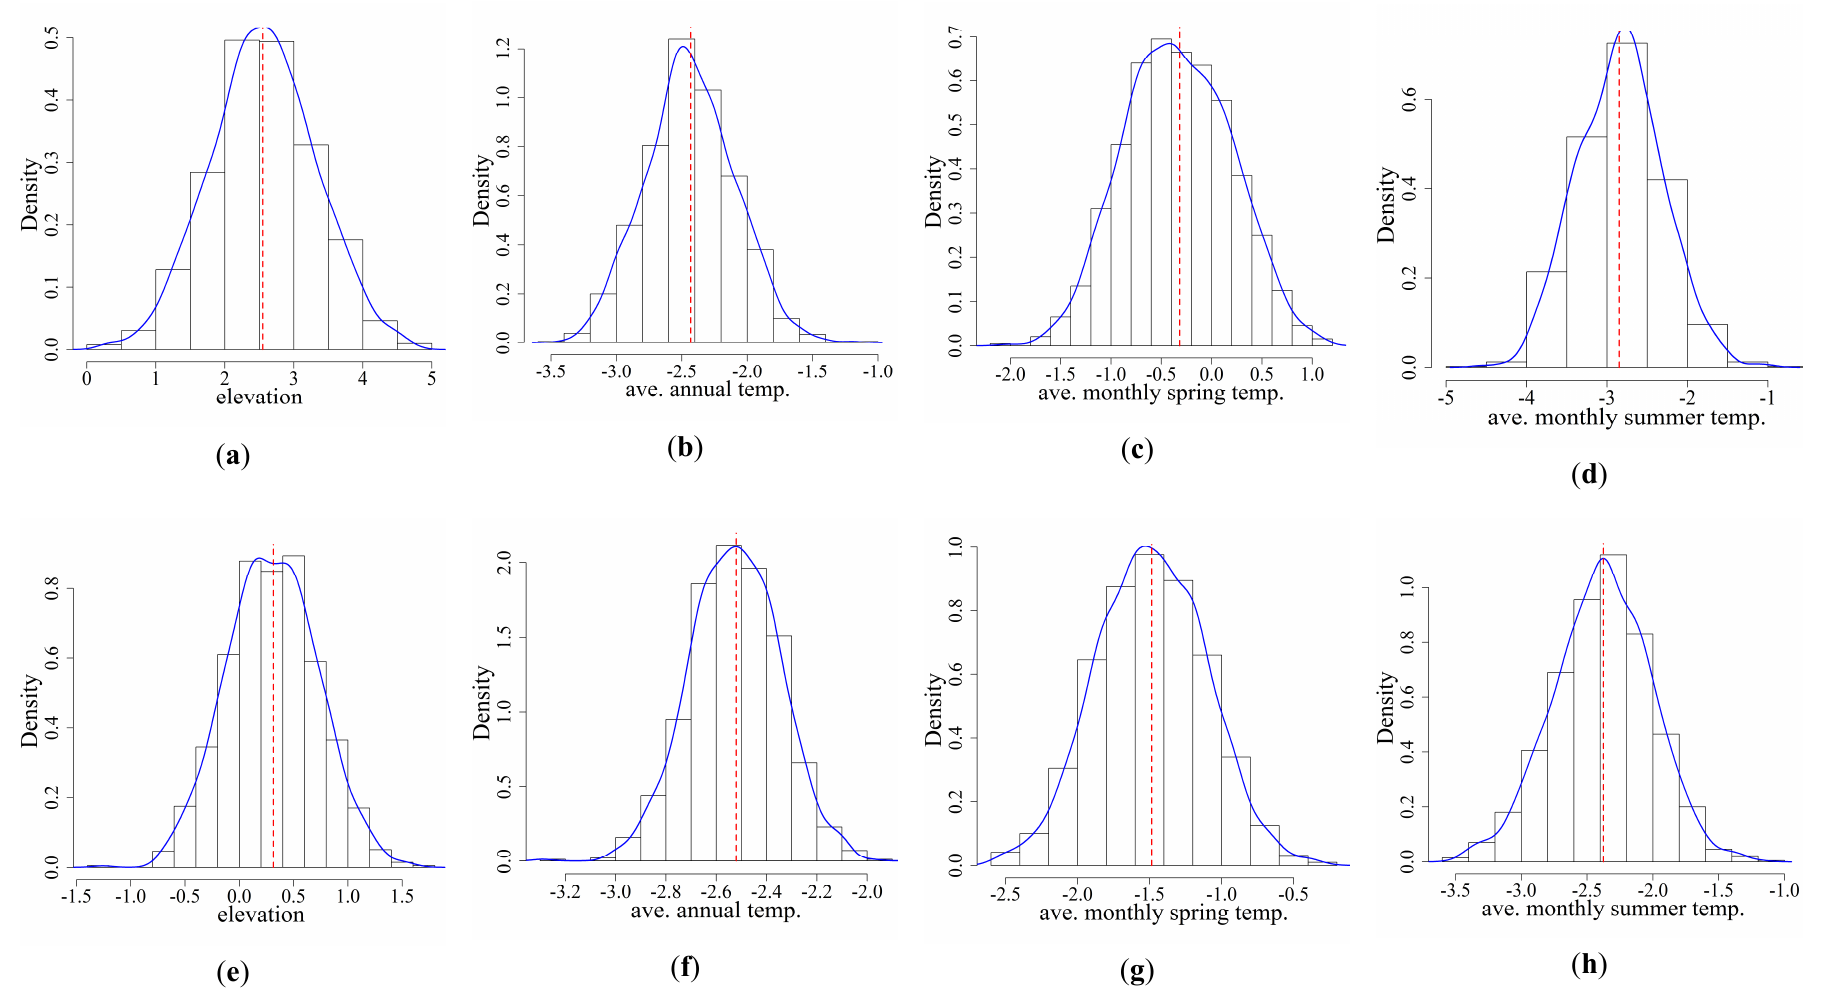
Figure 5. The bootstrap histogram of the coefficients in maximum entropy model for Abies : ( a ) elevation; ( b ) average annual